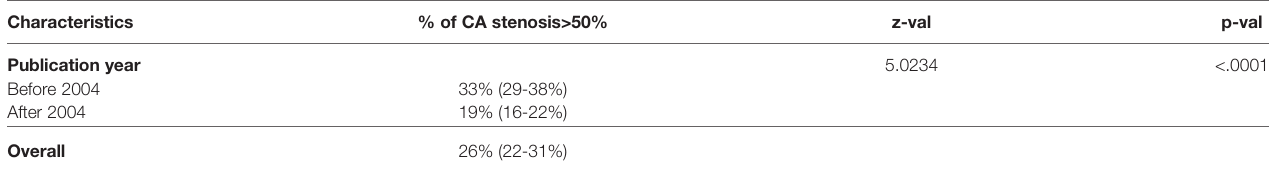
TABLE 2 | Results of meta-regression analysis with the R package metafor, showing that the year of publication and subsites of cancer were signi fi cant contributing factors to the heterogeneity.